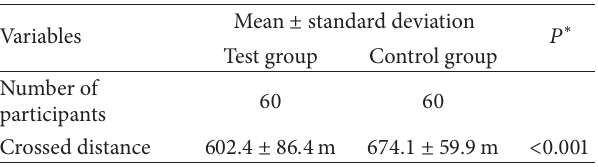
Table 4: Presentation of the groups studied with the level of HbA1c ≥ 8.0% and their controls in relation to the mileage